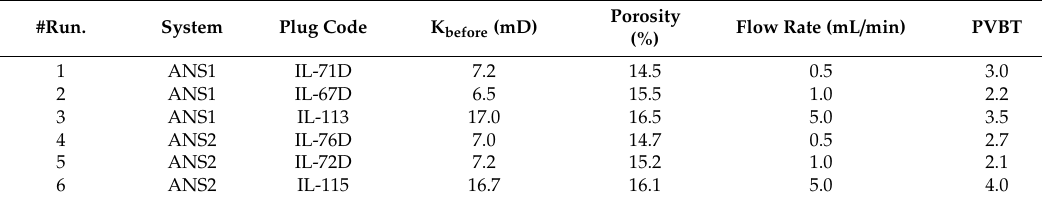
Table 1. Coreflood experiment